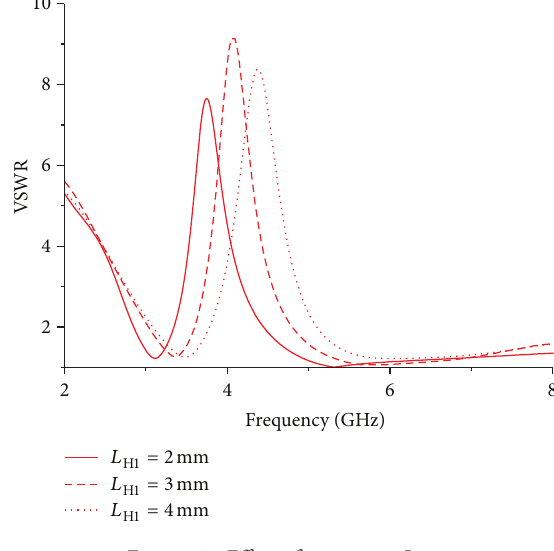
Figure 15: Effect of parameter 𝑅